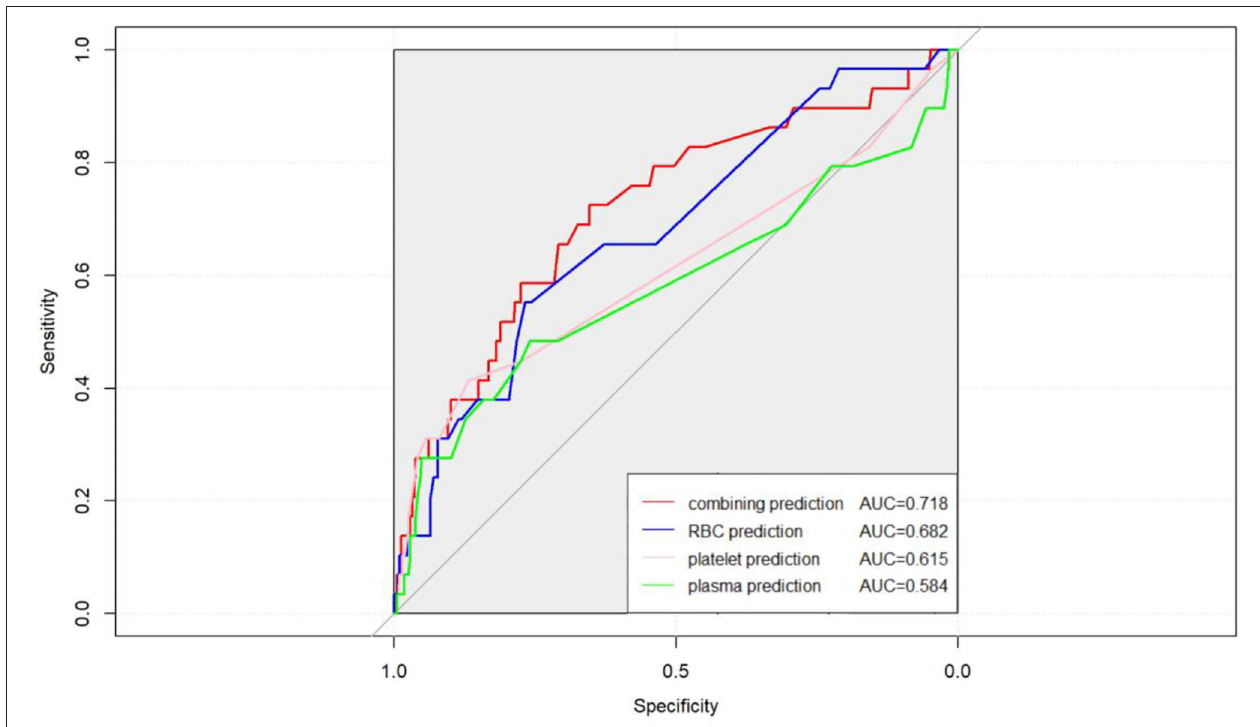
FIGURE 5 | Combining the transfusion amount of RBC, platelet, and plasma together had a better accuracy of peritransplant period prognostic assessment to heart transplantation (AUC = 0.718 vs. AUC = 0.682 for RBC, AUC = 0.615 for platelet, and AUC = 0.584 for plasma).